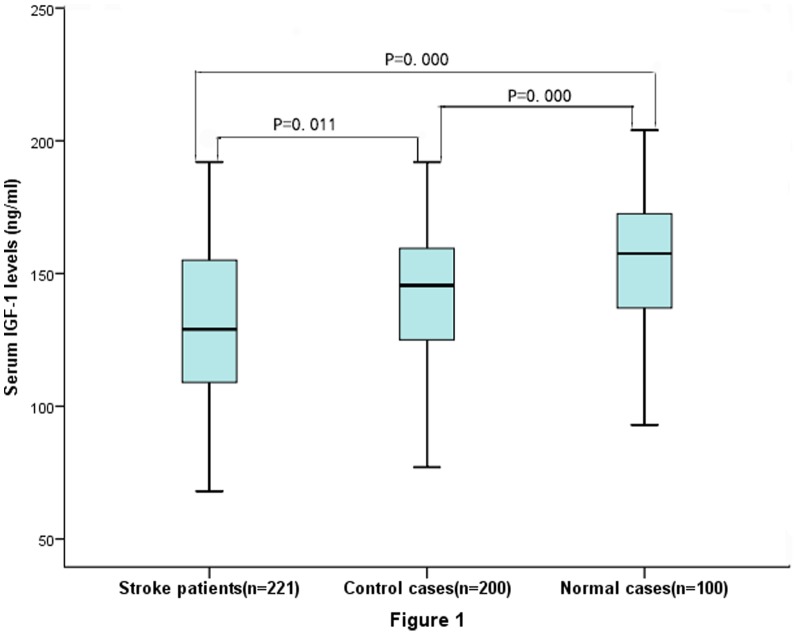
Serum IGF-I levels in acute ischemic stroke patients, control and normal group.Mann–Whitney U-test. All data are medians and in-terquartile ranges (IQR). Significantly higher in stroke patients as compared to control cases (p = 0.011); Significantly higher in stroke patients as compared to normal cases (p = 0.000).